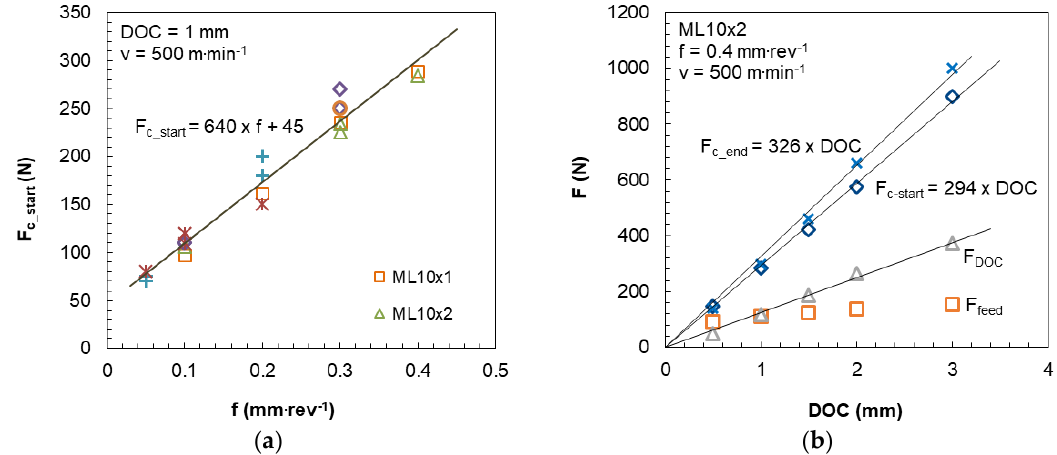
Figure 3. ( a ) Variation of the initial values of the main cutting force with feed ( f ), at fixed DOC and cutting speed. —30 µm CVD diamond coating [9]; —hardmetal tool coated with 6 µm CVD diamond [15]; —hardmetal tool coated with 25–30 µm CVD diamond [16]; —PCD tool [23]; ( b ) Effect of depth of cut in the initial values of cutting force for the ML10x2 inserts and end values of F c , for fixed feed and speed.